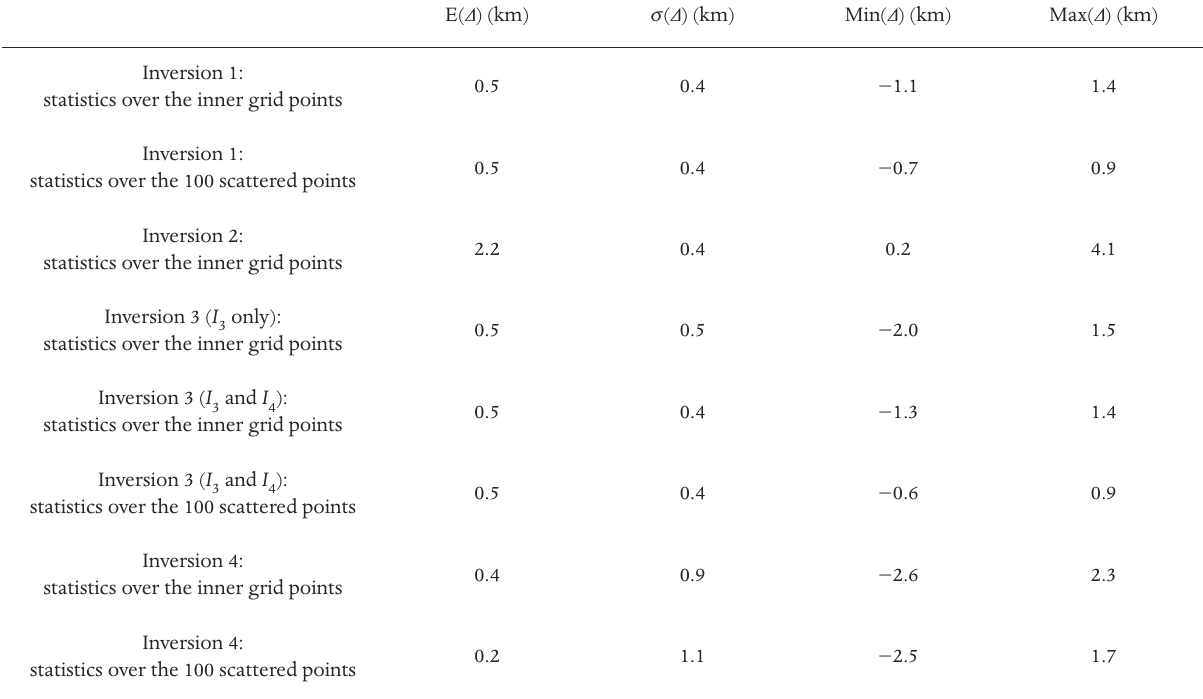
− . H estimated simulated